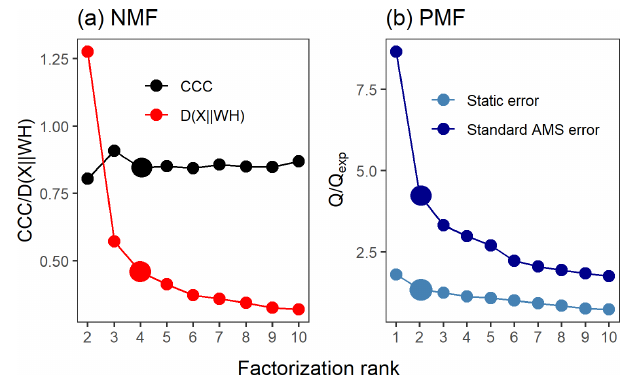
Figure 11. Factor number indices for particle-phase data (AMS). Estimation of the factorization rank for NMF in (a) , with CCC and D ( X || WH ), and for PMF in (b) , with Q/Q exp for the two error schemes. Larger points indicate the solution that was selected for more detailed